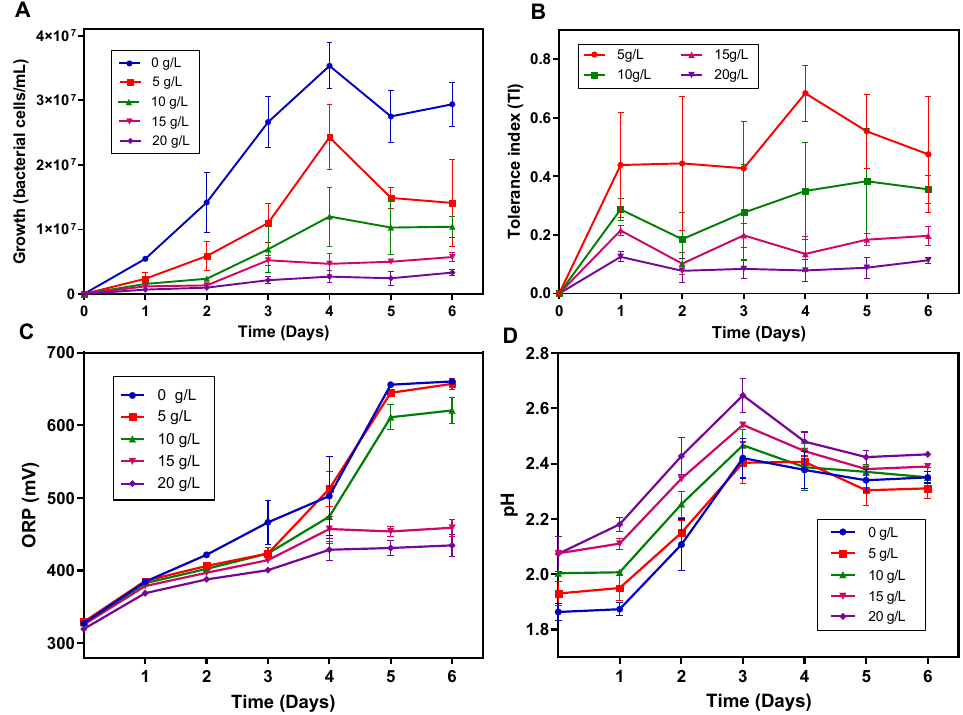
Figure 5. Growth ( A ), tolerance index ( B ), oxidation-reduction potential (ORP) ( C ) and pH ( D )